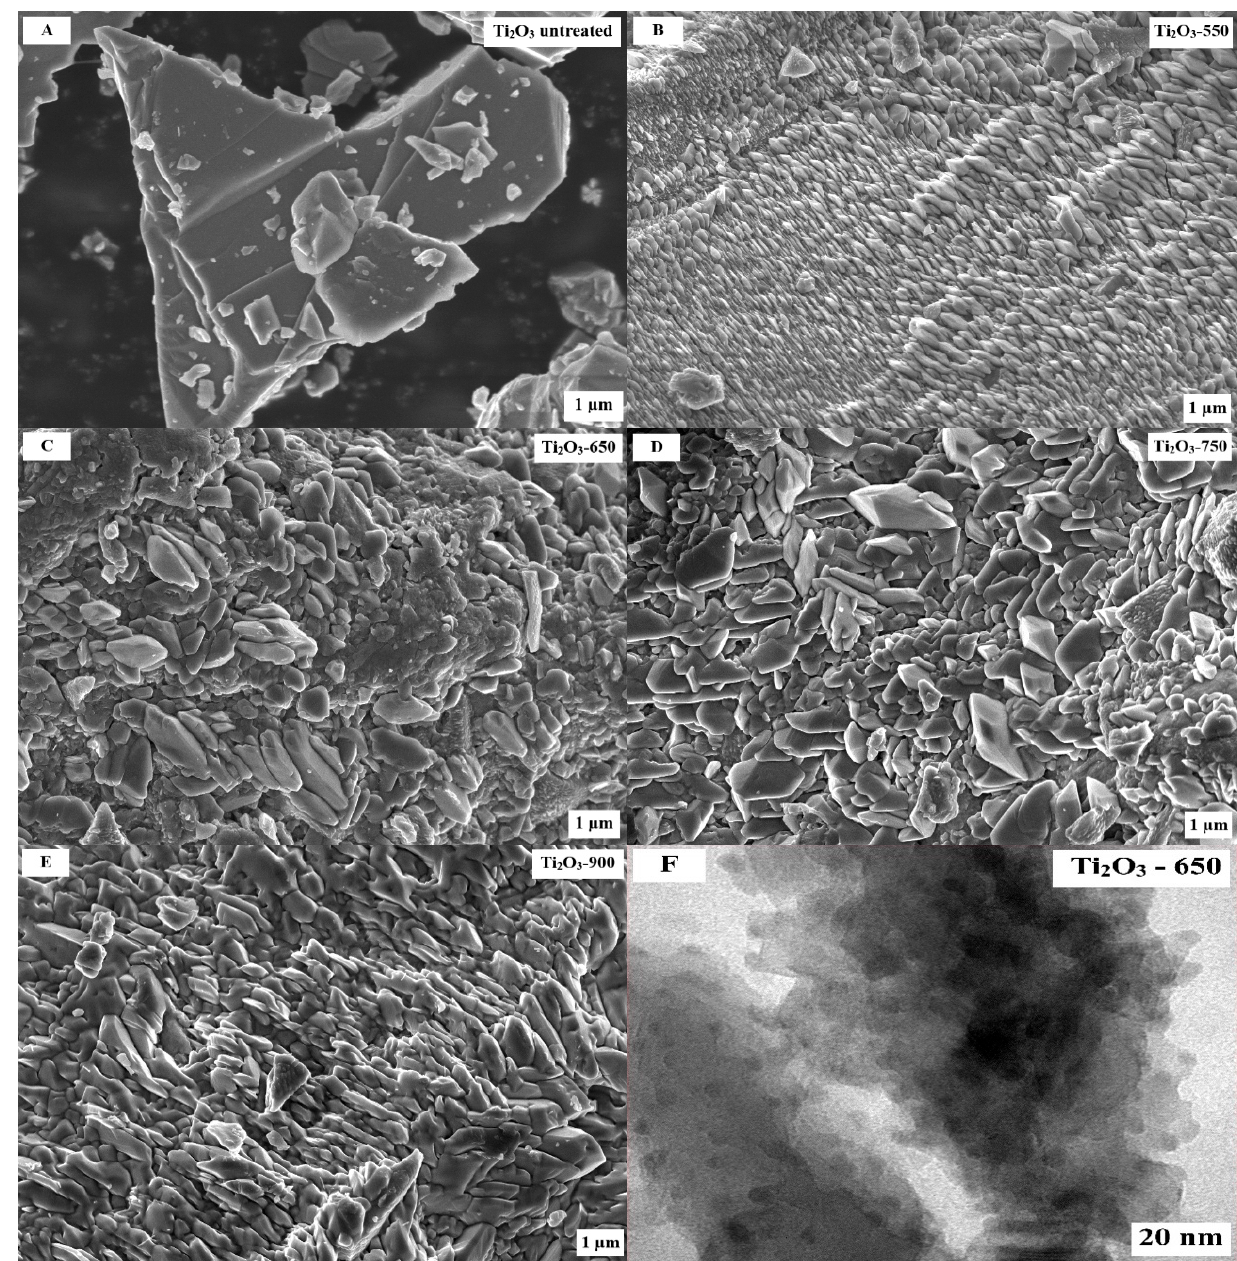
Figure 8. SEM images of Ti 2 O 3 untreated ( A ), Ti 2 O 3 -550 ( B ), Ti 2 O 3 -650 ( C ), Ti 2 O 3 -750 ( D ), Ti 2 O 3 -900 ( E ) and TEM image of Ti 2 O 3 -650 ( F ).